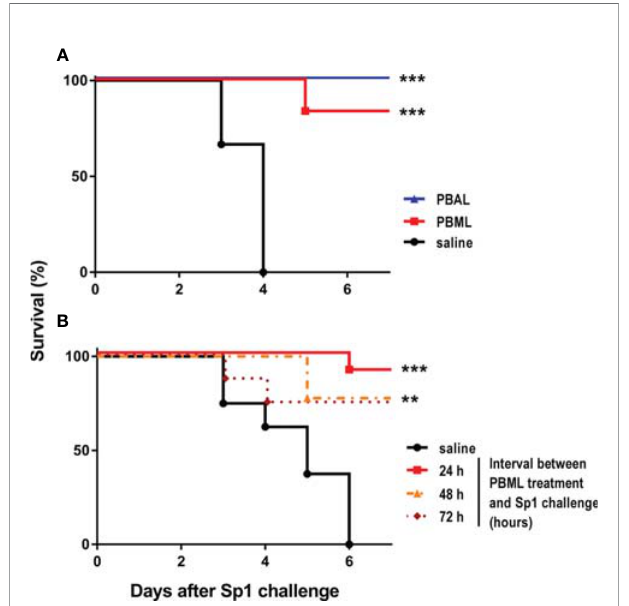
FIGURE 5 | Survival after Streptococcus pneumoniae (Sp1) challenge of mice pretreated with the Polyvalent Bacterial lysates. (A) Mice (n=6) received i.n. PABL or PMBL (18µg/30 µl) and 24 h later were challenged i.n. with the MLD of Sp1 (3x10 6 CFU/50 µl). (B) Mice (n=6) were i.n. treated with PMBL (18µg/30 µl) at 72, 48 and 24 h before being challenged with the MLD of Sp1 (3x10 6 CFU/50 µl). Survival rates were recorded for at least 7 days after challenge. Signi fi cant differences are shown by **p < 0.001, ***p < 0.0001, treated vs. untreated, Log-rank test (Mantel-Cox). Data are representative of more than three independent experiments.